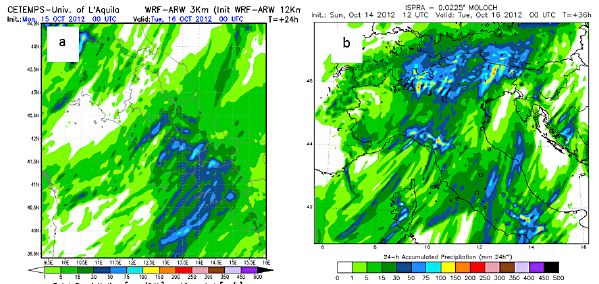
Figure 15. Daily precipitation (mm/24h) valid at 00:00UTC on 16 October 2012 simulated by (a) WRF-CETEMPS and (b) MOLOCH-ISPRA, both initialized by ECMWF at 12:00UTC, 14 October.